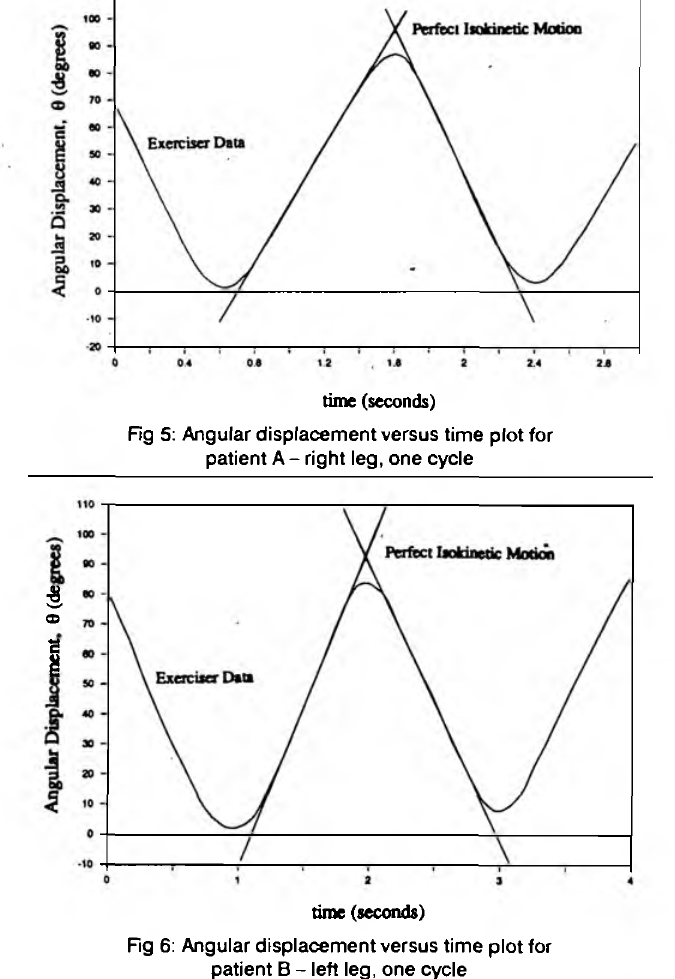
Fig 5: Angular displacement versus time plot for patient A - right leg, one cycle